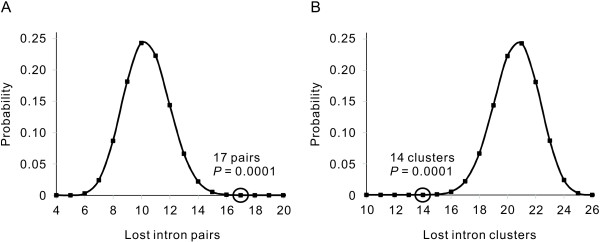
Adjacent introns tend to be lost together. The X-axis represents the pairs or clusters of adjacent intron losses and the Y-axis represents their probability of appearance when each intron is lost independently. (A) The probability distributions of the loss of adjacent intron pairs. In a case of n lost adjacent introns, the adjacent intron pairs were counted as n - 1. (B) The probability distributions of the loss of intron clusters. The cluster was defined as one or more adjacent introns. For more details of the method, see reference [20]. The observed patterns (marked by circles) have very small probabilities of occurrence via independent loss of each intron.